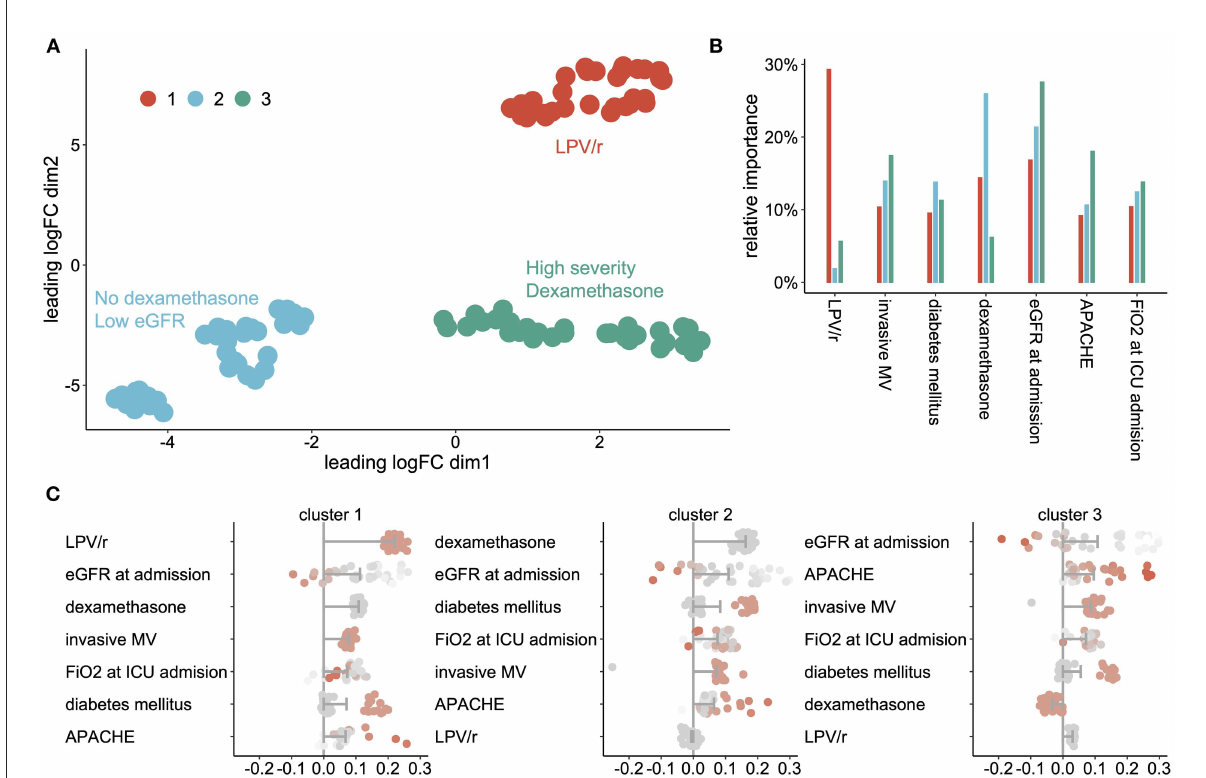
FIGURE2 AKI phenotypes’ (A) scatterplot showing the cluster of AKI patients projected on the UMAP, (B) relative importance of each variable across clusters, (C) shapley Additive Explanation (SHAP) values for each cluster of AKI patients, sorted by impact on AKI prediction. Bars represent the mean impact of each AKI associated factor for each cluster and dots represent individual patients. LPV/r Lopinavir/Ritonavir, DM Diabetes Mellitus; DXM Dexamethasone; MV Mechanical